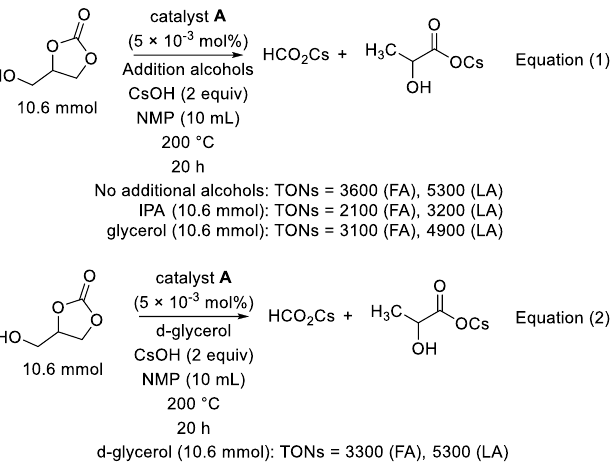
Scheme 4. Plausible reaction mechanism. 3. Conclusions We report the first transfer hydrogenation of GC without additional hydrogen sources to the best of our knowledge. The control experiments and gas analysis confirm the reduction route induced by Ir(triNHC) catalysts. The reaction results of GC with deu- terated glycerol imply that dissociated bicarbonates and glycerol alkoxides from GC are readily reacted before the participation of the external hydride sources in the reaction. The bimetallic catalysts are favored in coordinating both reactants (bicarbonates and glycerol alkoxides) inside the reaction sphere, as illustrated in the proposed reaction mechanism. Supplementary Materials: The following supporting information can be downloaded at: www.mdpi.com/xxx/s1, Scheme S1. The reaction of ethylene carbonate, Scheme S2. The reaction of